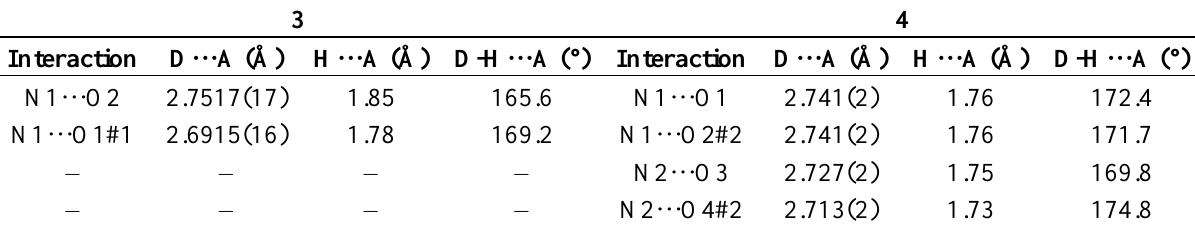
Table 2. Hydrogen-bonding parameters for compounds 3 and 4 . Symmetry